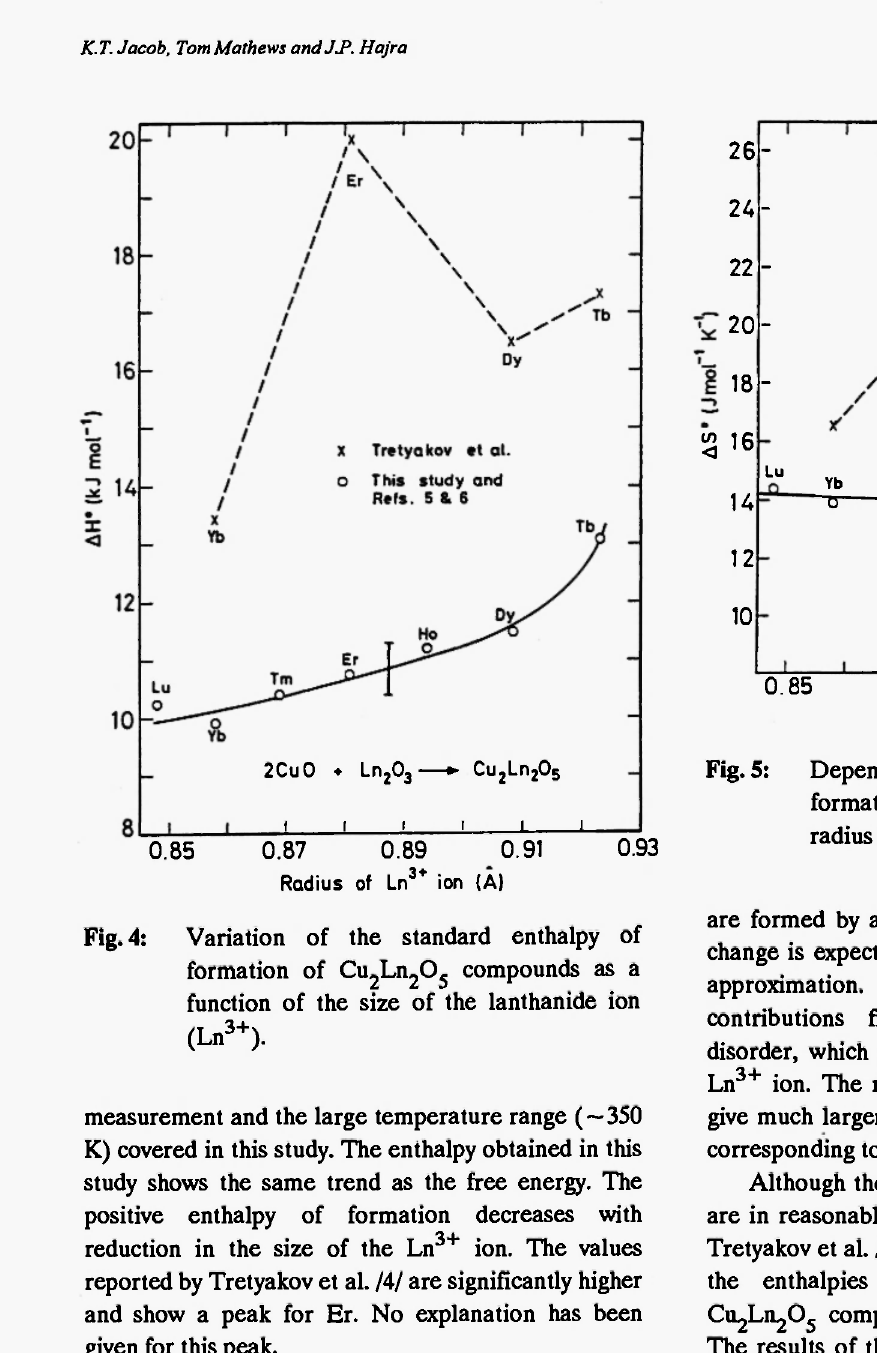
Fig. 4: Variation of the standard enthalpy of formation of Cu Ln O compounds as a 2 2 s function of the size of the lanthanide ion (Ln 3+ ). measurement and the large temperature range (—350 K) covered in this study. The enthalpy obtained in this study shows the same trend as the free energy. The positive enthalpy of formation decreases with reduction in the size of the Ln 3+ ion. The values reported by Tretyakov et al. /4/ are significantly higher and show a peak for Er. No explanation has been given for this peak.